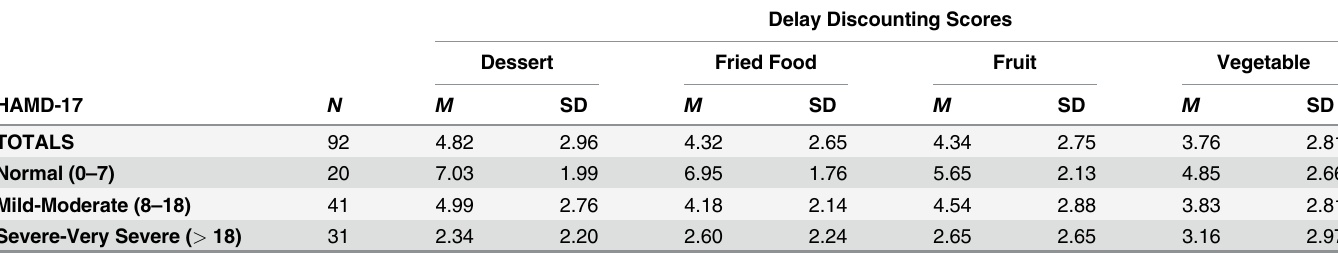
Table 2. Delay discounting scores for participants in each category of